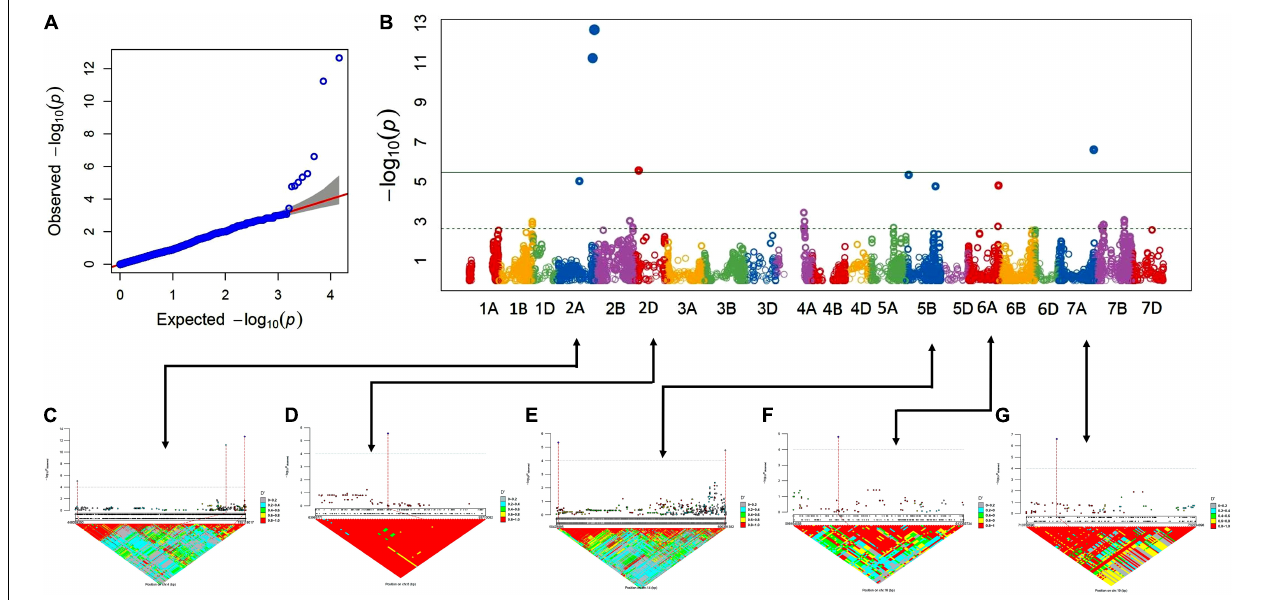
FIGURE 3 | GWAS results for stripe rust resistance. (A,B) Q-Q and Manhattan plots of SNPs associated with stripe rust resistance. Horizontal line depicts significance threshold level. (C–G) Manhattan plots of SNP-specific genomic region clusters on chromosomes 2A, 2D, 5B, 6A, and 7A and corresponding linkage disequilibrium (LD) D (cid:48) patterns. SNP names and corresponding local LD value patterns are in the bottom part of the graph. Numbers within the diamonds of the triangular LD matrix are D (cid:48) values. GWAS, genome-wide association study; SNPs, single-nucleotide polymorphisms. TABLE 3 | Summary of the QTL mapping using GWAS in the present study. QTLs SNP marker Alleles Effective allele Chr Pos. (Mb) MAF FDR Adj. p -val Effect p -Val